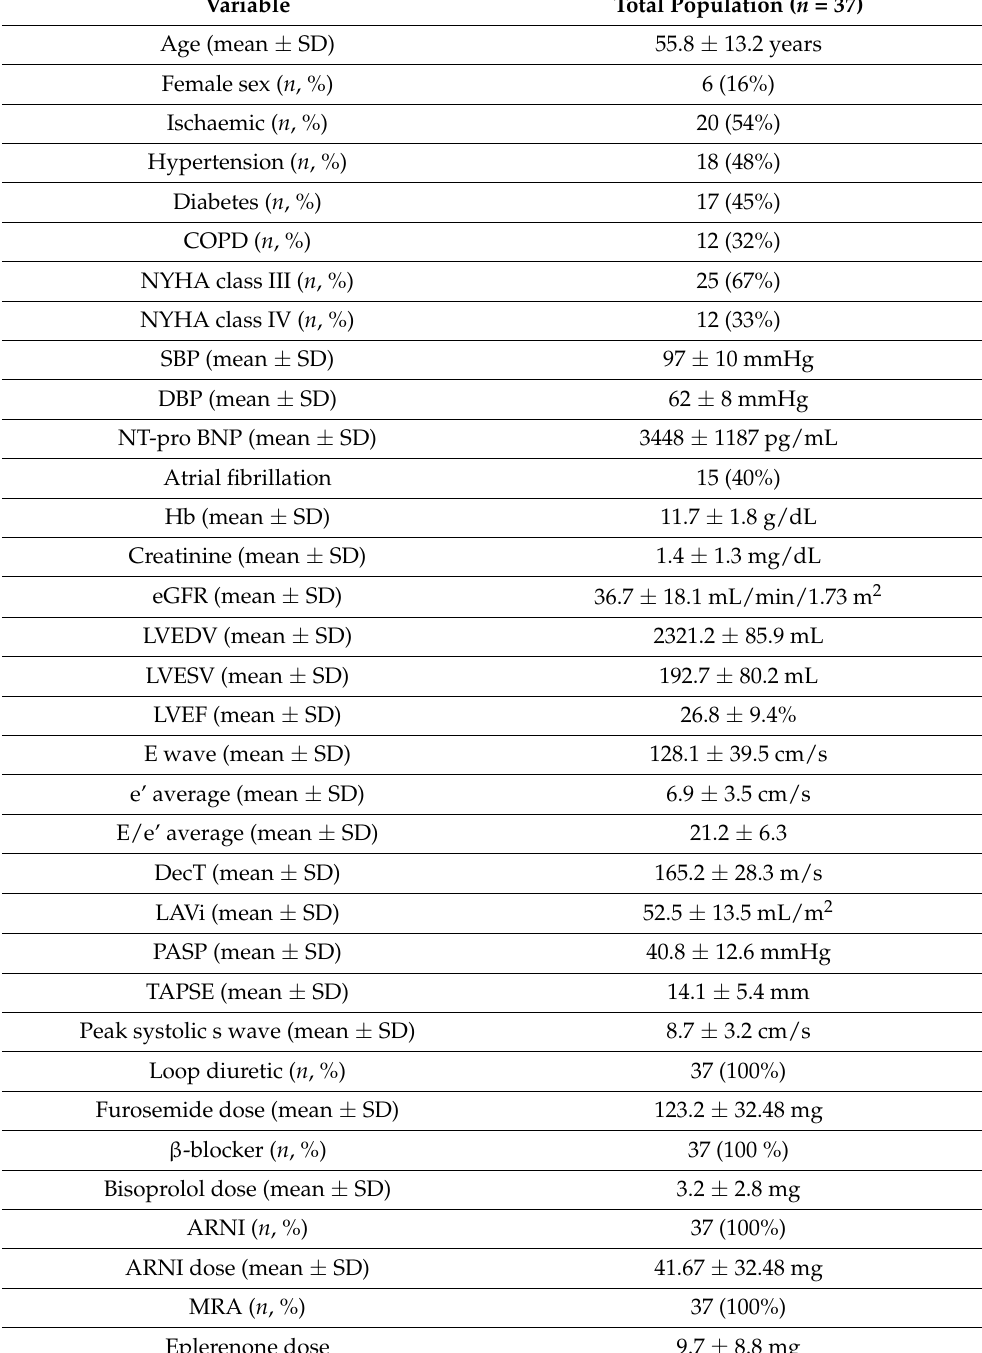
Table 1. Baseline clinical and echocardiographic characteristics of the study